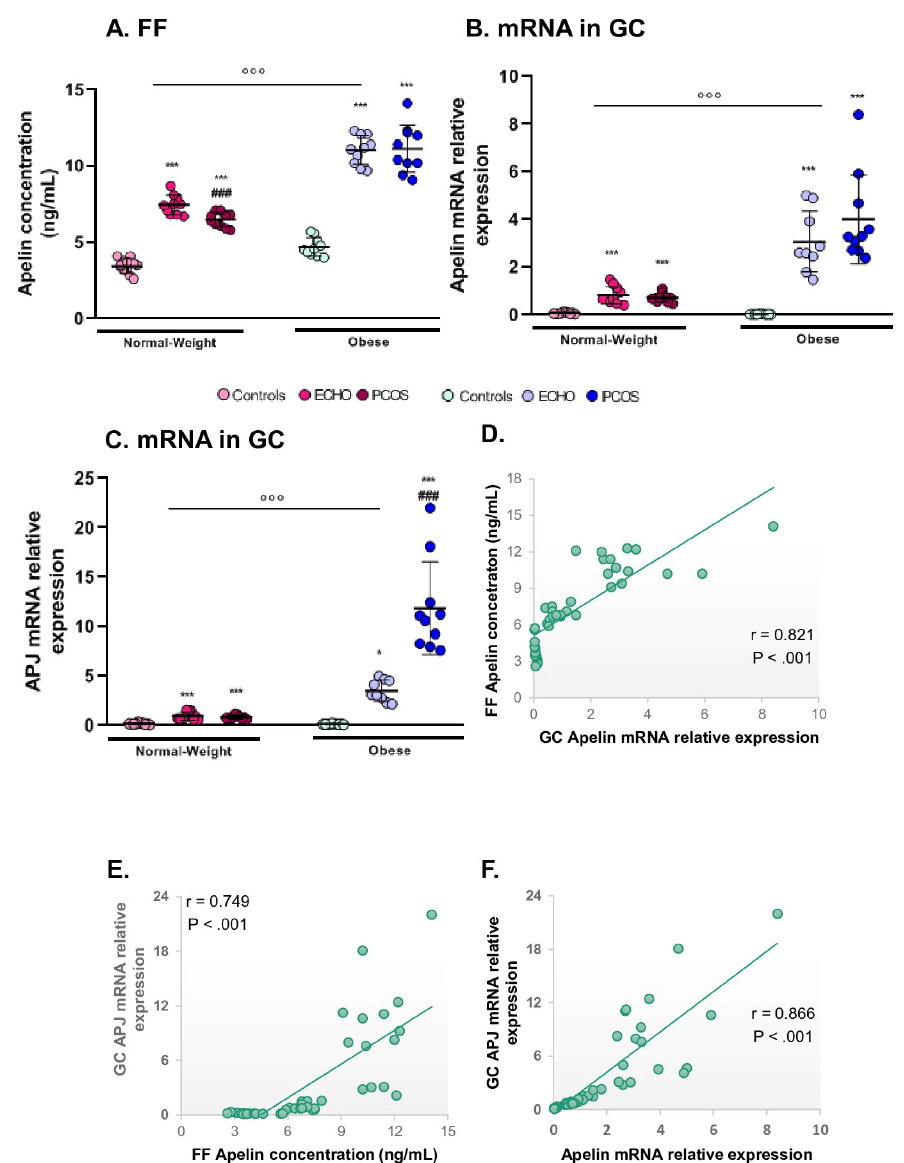
Figure 4. Follicular fluid apelin concentration, mRNA expression of apelin and its receptor, APJ, in GCs of obese and normal - weight PCOS, ECHO, and controls groups and correlations of apelin FF levels and apelin or APJ mRNA expression in GCs. ( A ) Follicular fluid (FF) apelin concentration assessed by ELISA; ( B ) apelin and ( C ) APJ mRNA levels in granulosa cells (GC) quantified by RT - PCR within the six different groups; ( D ) correlation between FF concentration and GC expression of apelin; correlations between APJ mRNA levels in GCs; and ( E ) apelin FF concentration and ( F ) apelin mRNA levels in GCs. The values are expressed as mean ± standard errors of means ( n = 12 for normal - weight controls, n = 13 for normal - weight ECHO, n = 13 for normal - weight PCOS, n = 15 for obese controls, n = 15 for obese ECHO, and n = 10 for obese PCOS). °°° indicates significant difference ( p < 0.001) between normal - weight and obese subjects; *** indicates significant difference ( p < 0.001) vs. controls; ### indicates significant difference ( p < 0.001) vs. ECHO women.